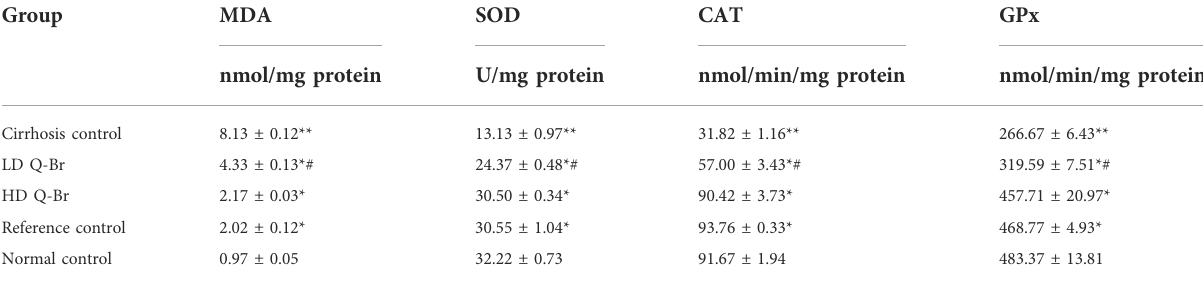
TABLE 3 Impact of Q-Br treatment on the liver MDA level and antioxidant enzymatic activity of the rats after 15 weeks in sub-chronic liver injury induced by TAA. Group MDA